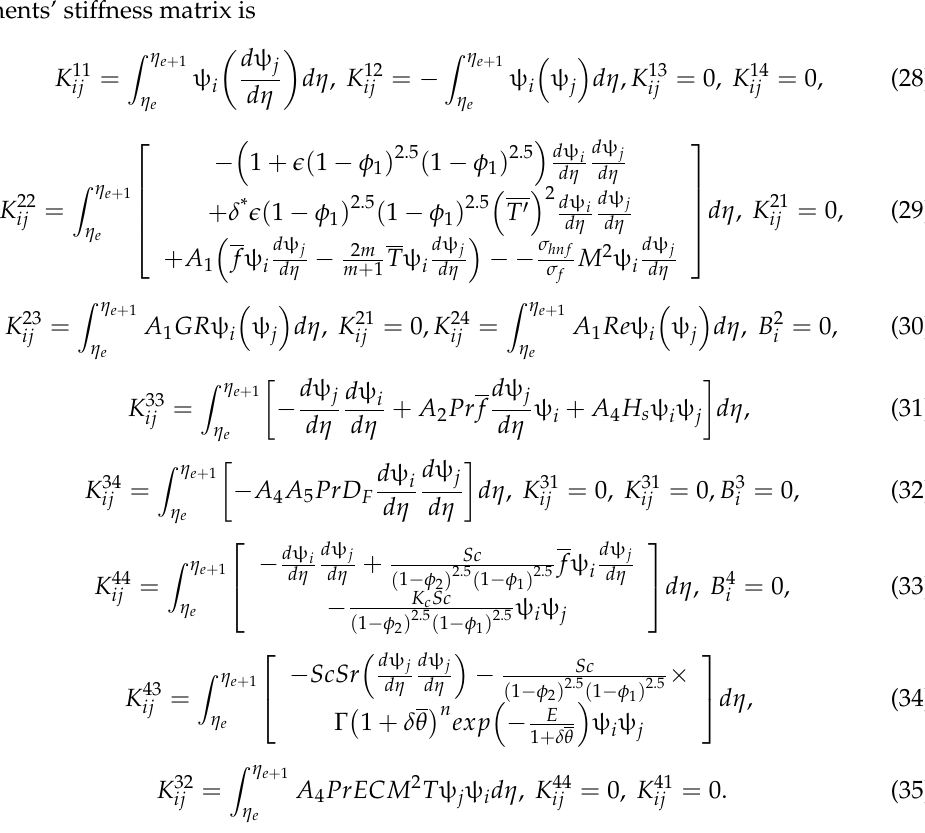
Figure 5. Division of physical domain into finite elements.